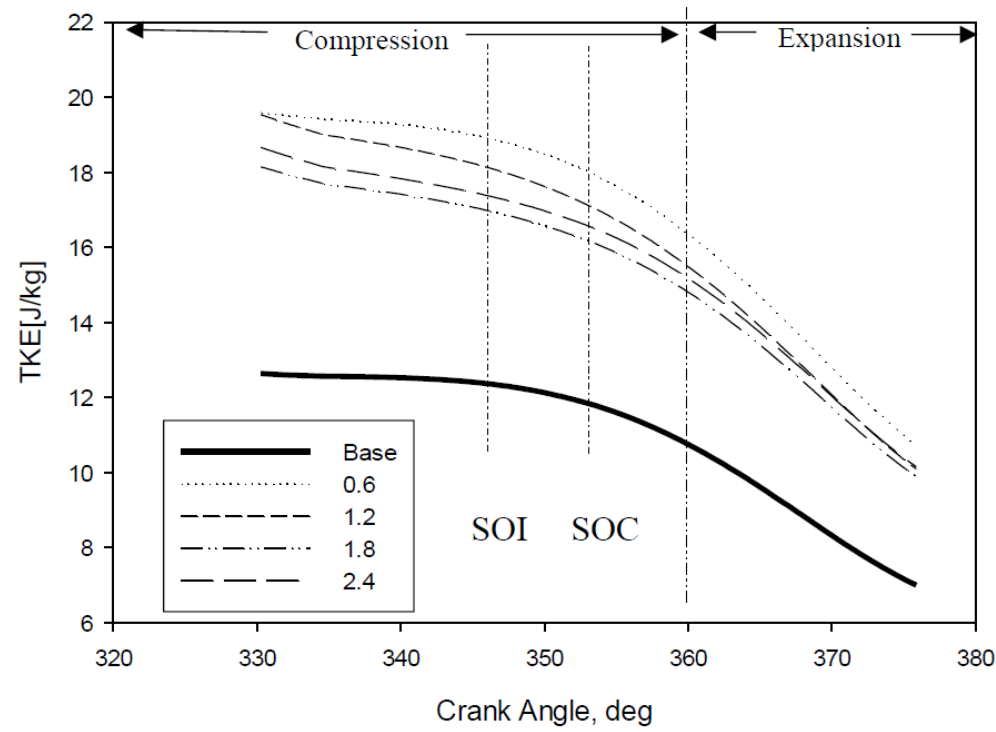
Figure 8. The plot of TKE against the crank angle.